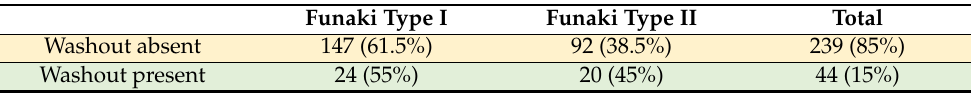
Table 5. Types of UF according to the Funaki classification and types of dynamic enhancement in the study